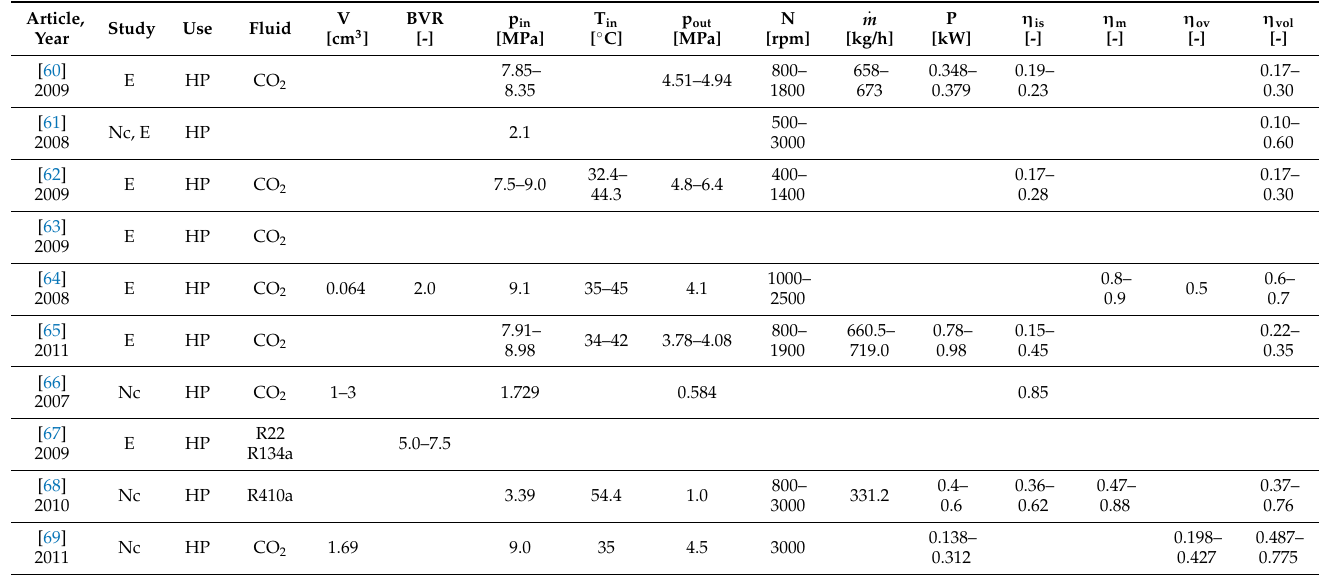
Table 3. Experimental and numerical results related to two-phase vane